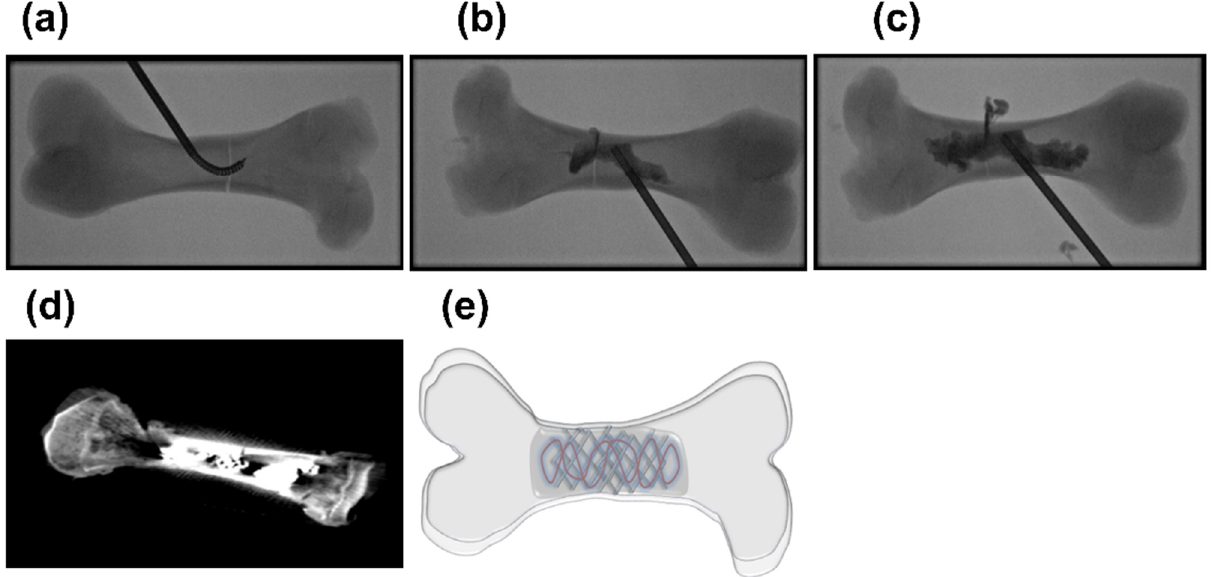
Figure 2. Percutaneous-reinforced osteoplasty procedure [12]. ( a ) Access to the intramedullary canal is established with a bone needle through a cortical hole adjacent to the fracture line, ( b ) cement injection (initial phase) via bone cannula, ( c ) cement injection (final phase), ( d ) stent and wire scaffolding in position following cementoplasty, ( e ) artistic representation of stent-wire-cement scaffolding strategy (percutaneous-reinforced osteoplasty). (Parts of figures were reprinted with permission, © 2020 Springer, [12]).